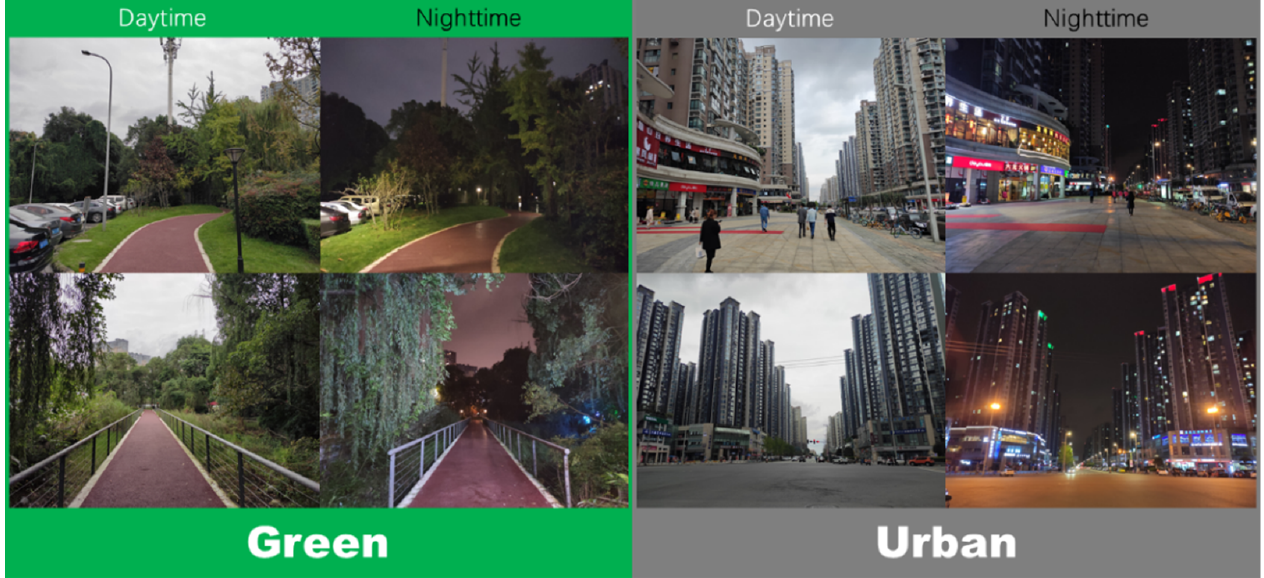
Figure 1. Location of the study area and the two walking routes in the green space and urban area.